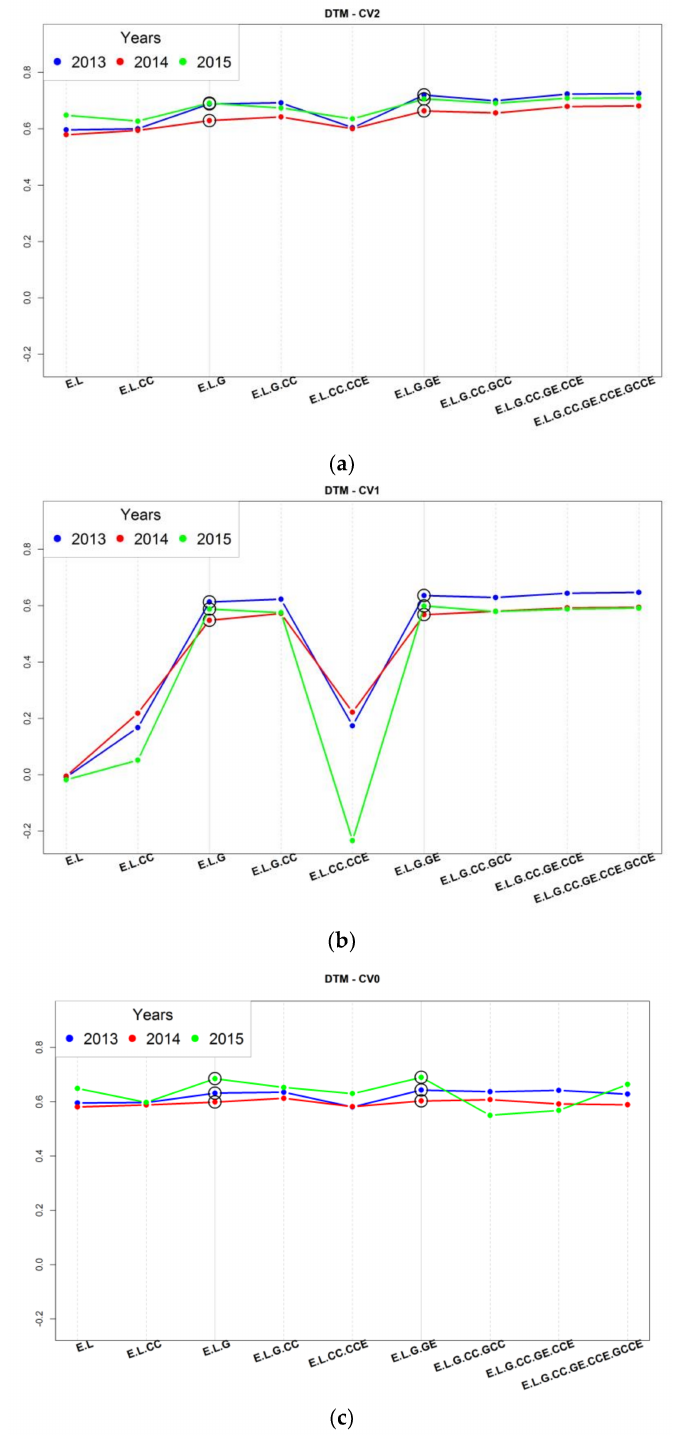
Figure 4. Average prediction accuracy obtained for the nine models for days to maturity (DTM) using the CV2 ( a ); CV1 ( b ); and CV0 ( c ) cross-validation schemes. The three different colors represent the years for which the prediction was carried